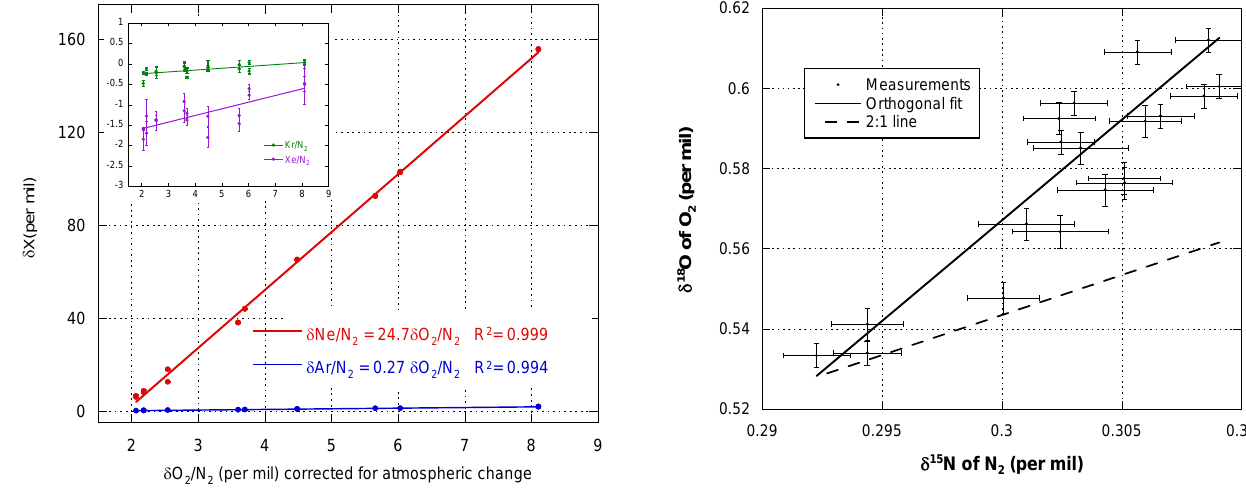
Fig. 4. Ratios of noble gases to N 2 from the lock-in zone. Er- rors shown are 1 σ , derived from the pooled standard deviation of replicate flasks and are generally smaller than the points for Ar / N 2 , Ne / N 2 and O 2 / N 2 . Note however that the model-based correction for atmospheric changes in O 2 introduces additional uncertainty that we have not shown in the plot (see text). Intercepts for the linear fits only reflect the choice of the O 2 / N 2 standard and have been omitted from the plot for clarity.